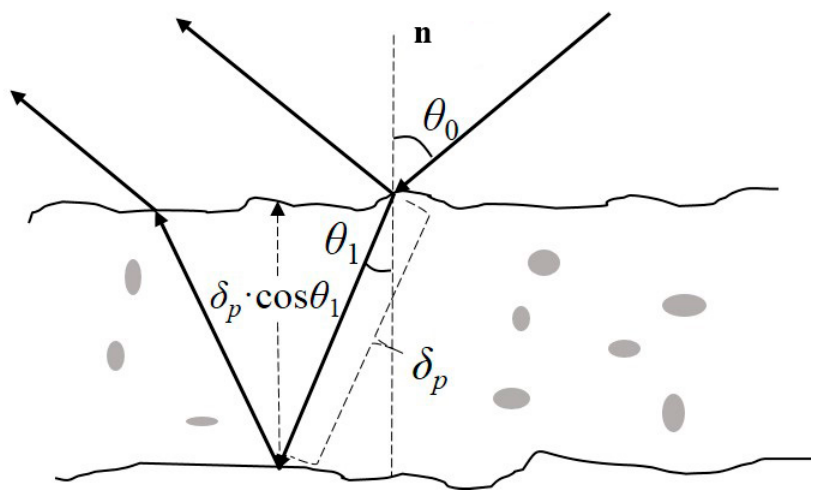
Figure 6. Propagation of an electromagnetic wave and its penetration distance in soil.